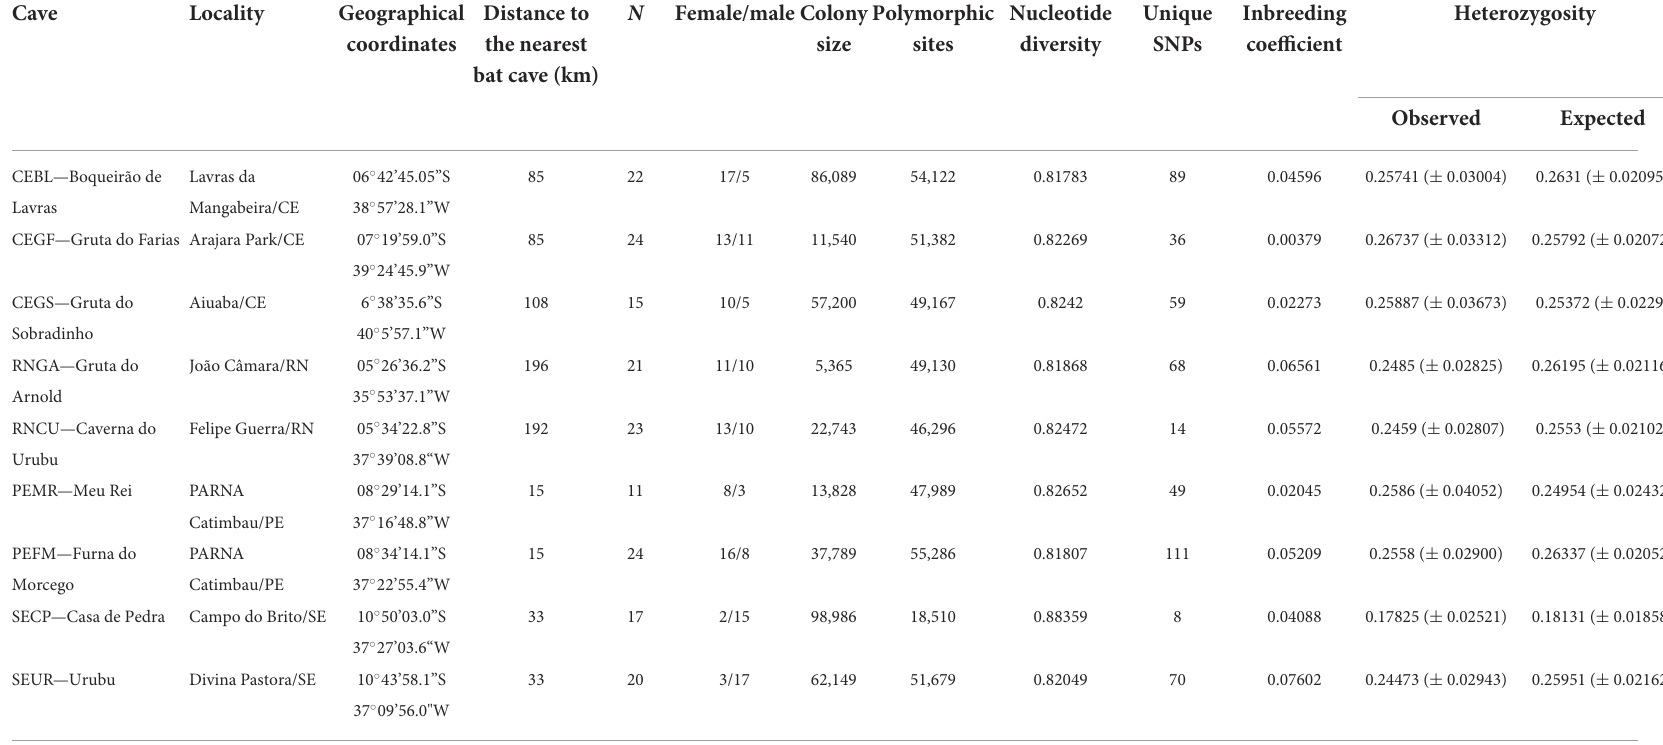
TABLE 1 Geographical and population data for Pteronotus gymnonotus per bat cave in northeastern Brazil, including sampling location, the number of genetic samples collected ( N ), and the division of samples by gender (female/male), estimated colony size, and genetic diversity information for each